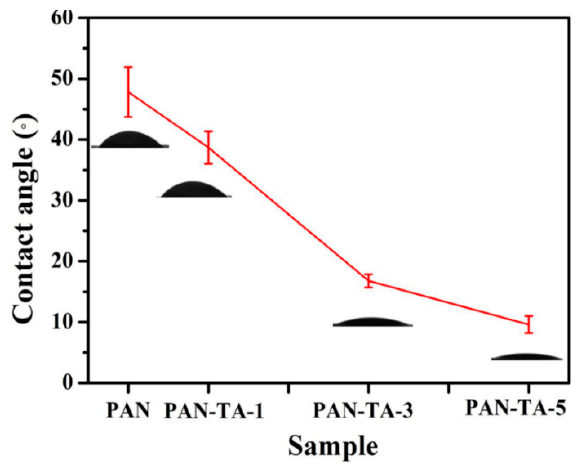
Figure 3. Contact angles of di ff erent samples (PAN, PAN–TA-1, PAN–TA-3, PAN–TA-5).